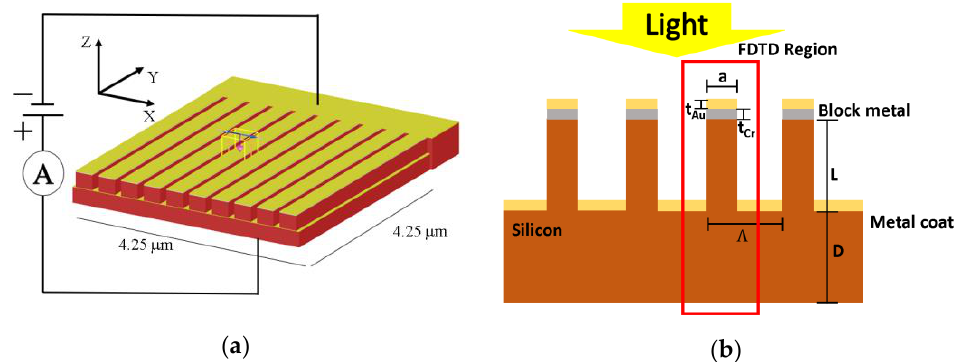
Figure 1. Silicon grating photodetector fabricated using the MACE method. ( a ) Device area, ( b ) device cross-section.